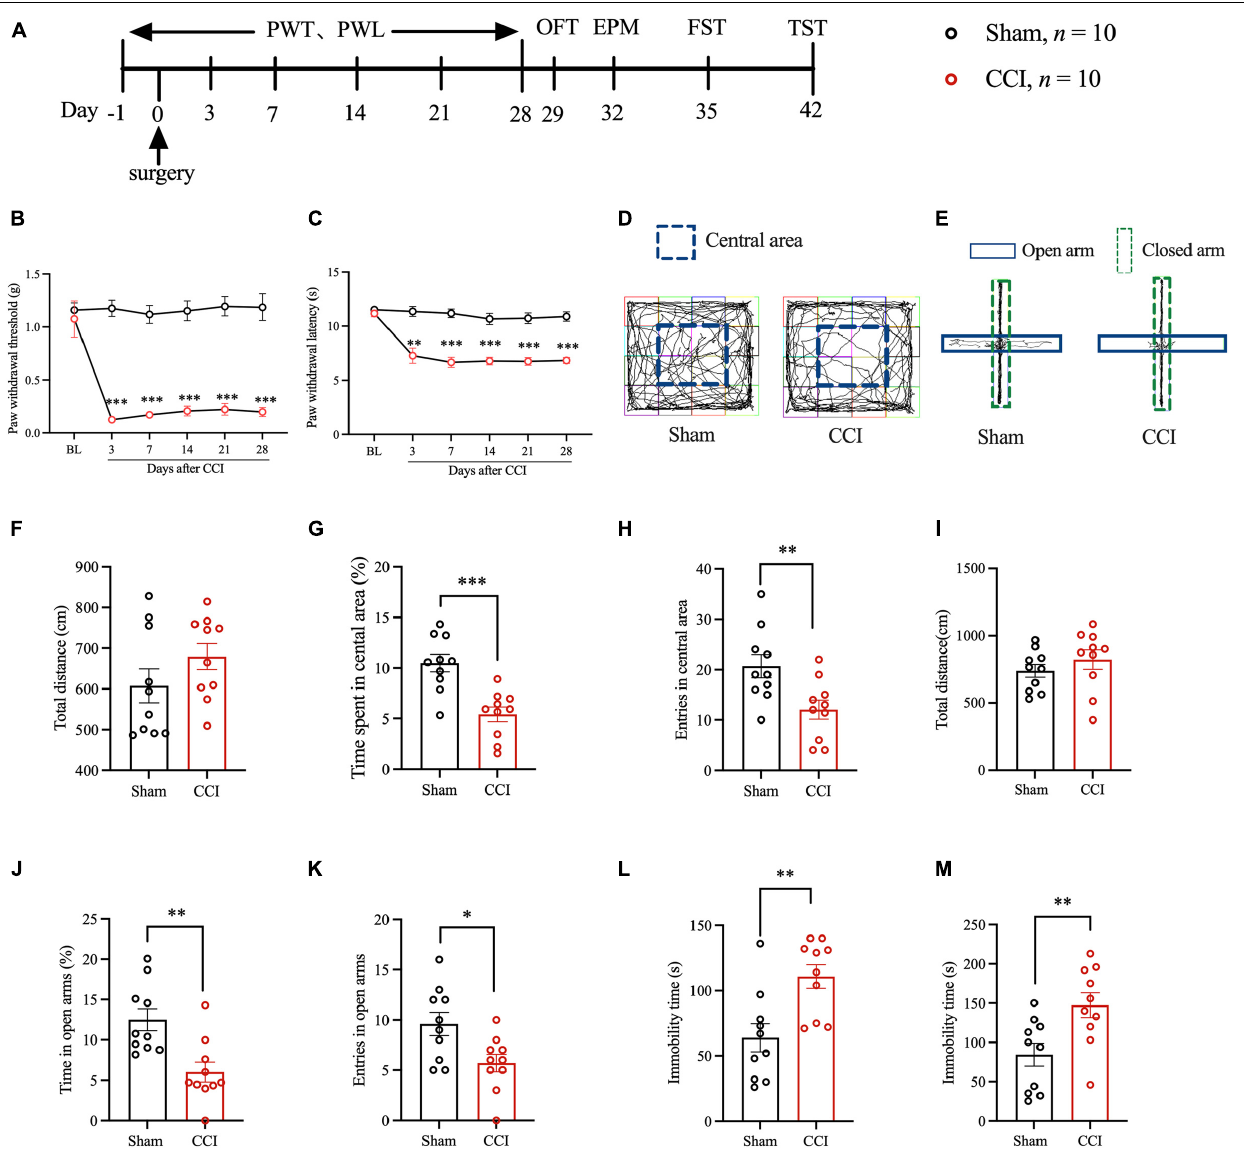
FIGURE 1 | Peripheral nerve injury induced hyperalgesia and anxiety- and depression-like behaviors in mice. (A) The schematic diagram of the experimental arrangement. (B,C) The paw withdrawal threshold and paw withdrawal latency of mice at -1, 3, 7, 14, 21, and 28 days after CCI ( n = 10, ∗∗ P < 0.01 vs. Sham, ∗∗∗ P < 0.001 vs. Sham); (D) OFT trajectory. (F) The total movement distance of mice was observed during the OFT. (G) The proportion of residence time in the central area ( n = 10, ∗∗∗ P < 0.001 vs. Sham). (H) The number of entries of the central area ( n = 10, ∗∗ P < 0.01 vs. Sham); (E) EPM trajectory. (I) The total movement distance of mice during the EPM. (J) The proportion of residence time in the open arm ( n = 10, ∗∗ P < 0.01 vs. Sham). (K) The number of entries of the open arm ( n = 10, ∗ P < 0.05 vs. Sham); (L,M) The immobility time during the FST and TST (n = 10, ∗∗ P < 0.01 vs.